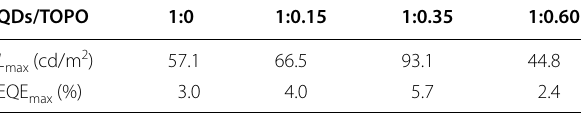
Table 2 Optoelectronic properties of CsPbI composite-converted red LEDs